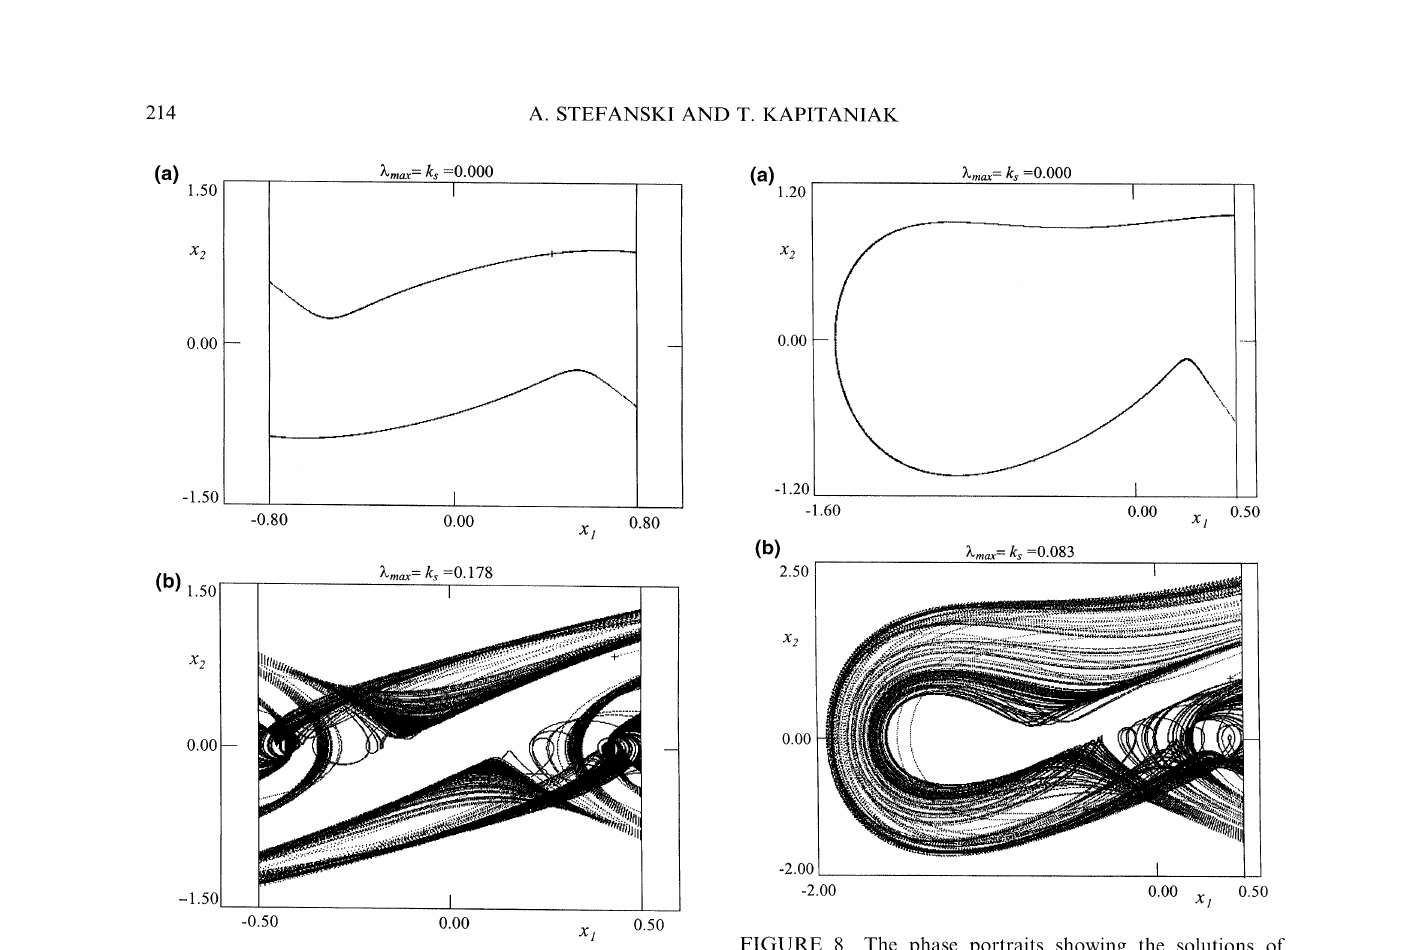
FIGURE 8 The phase portraits showing the solutions of Duffing oscillator with impacts (single buffer Eq. (29)) and the largest Lyapunov exponent Ama associated with